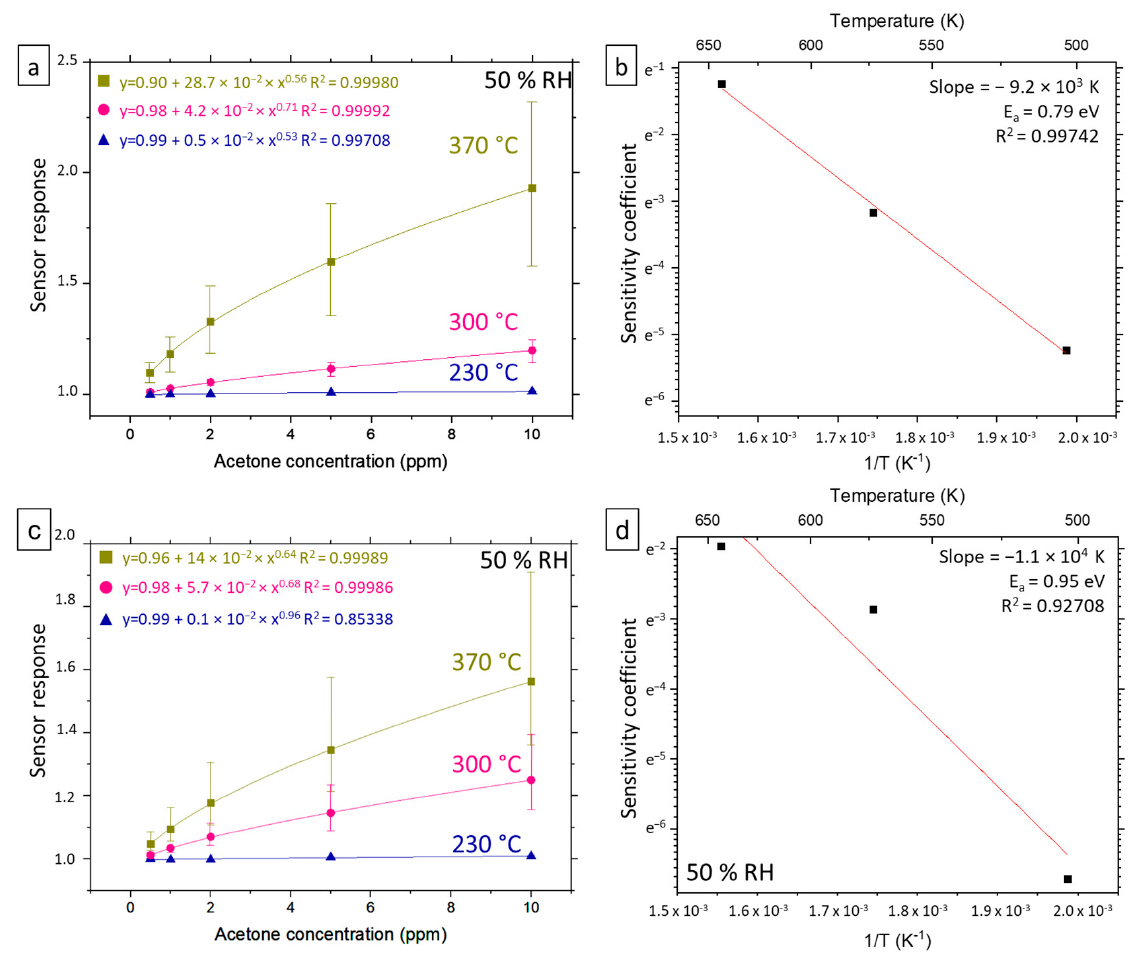
Figure 6. ( a ) (resp. ( c )) Evolution of D Low (resp. I Low ) devices response towards acetone under 50% RH humid atmosphere and different working temperature. The symbol represent the mean calculated from 4 (resp. 3) devices and the upper and lower lines represent respectfully the higher and lower sensor response calculated. Sensor response values were calculated from the third cycle of exposure at 230 ◦ C and 300 ◦ C and the sixth one at 370 ◦ C. Allometric fits were done in accordance with Equation (8). ( b , d ) Evolution of sensitivity coefficient k ( T ) as a function of inverse